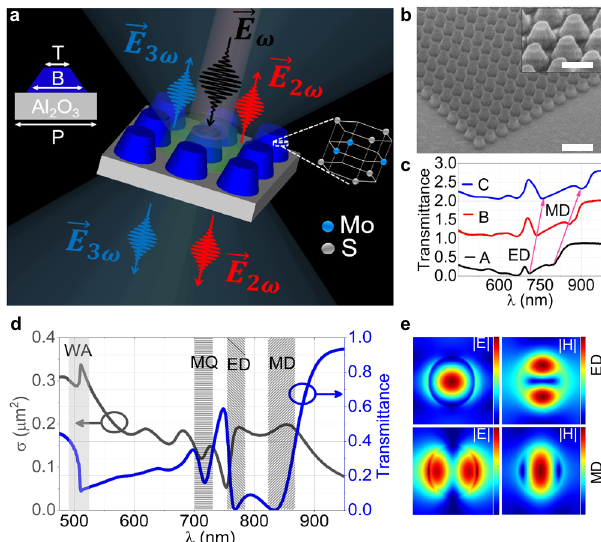
Fig. 1 Nonlinear TMDC metasurfaces. a Schematic of MoS 2 truncated cone metasurface. For metasurface C, T = 150 nm, B = 240 nm, P = 300 nm and height = 150 nm, as shown in the top left corner. The bottom-right inset shows the lattice structure of the 2H-stacked MoS 2 . b The SEM image of the fabricated metasurface C with a scale bar of 2 µ m while the inset scale bar is 500 nm. c The measured transmission spectrum of three metasurfaces A – C. For clarity, spectra are vertically displaced by T ¼ 1 for each metasurface. Arrows show the change in the spectral position of electric dipole (ED) and magnetic dipole (MD) as a function of the aspect ratio of truncated cone meta-atoms. d Calculated cartesian multipoles expansion of metasurface C, where σ represents the effective scattering cross-section. The patterned regions represent the position of magnetic quadrupole (MQ), ED and MD, whilst the light grey region shows the position of fi rst-order Wood ’ s anomaly WA. e Normalised electric and magnetic fi eld pro fi les at the resonant wavelengths: 770nm and 840 nm,